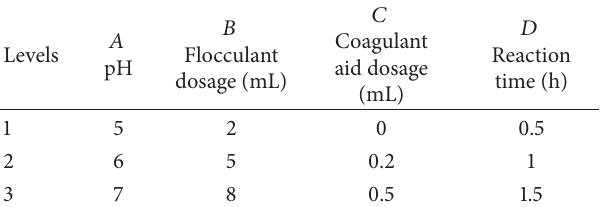
Table 1: Factors and levels of orthogonal test.